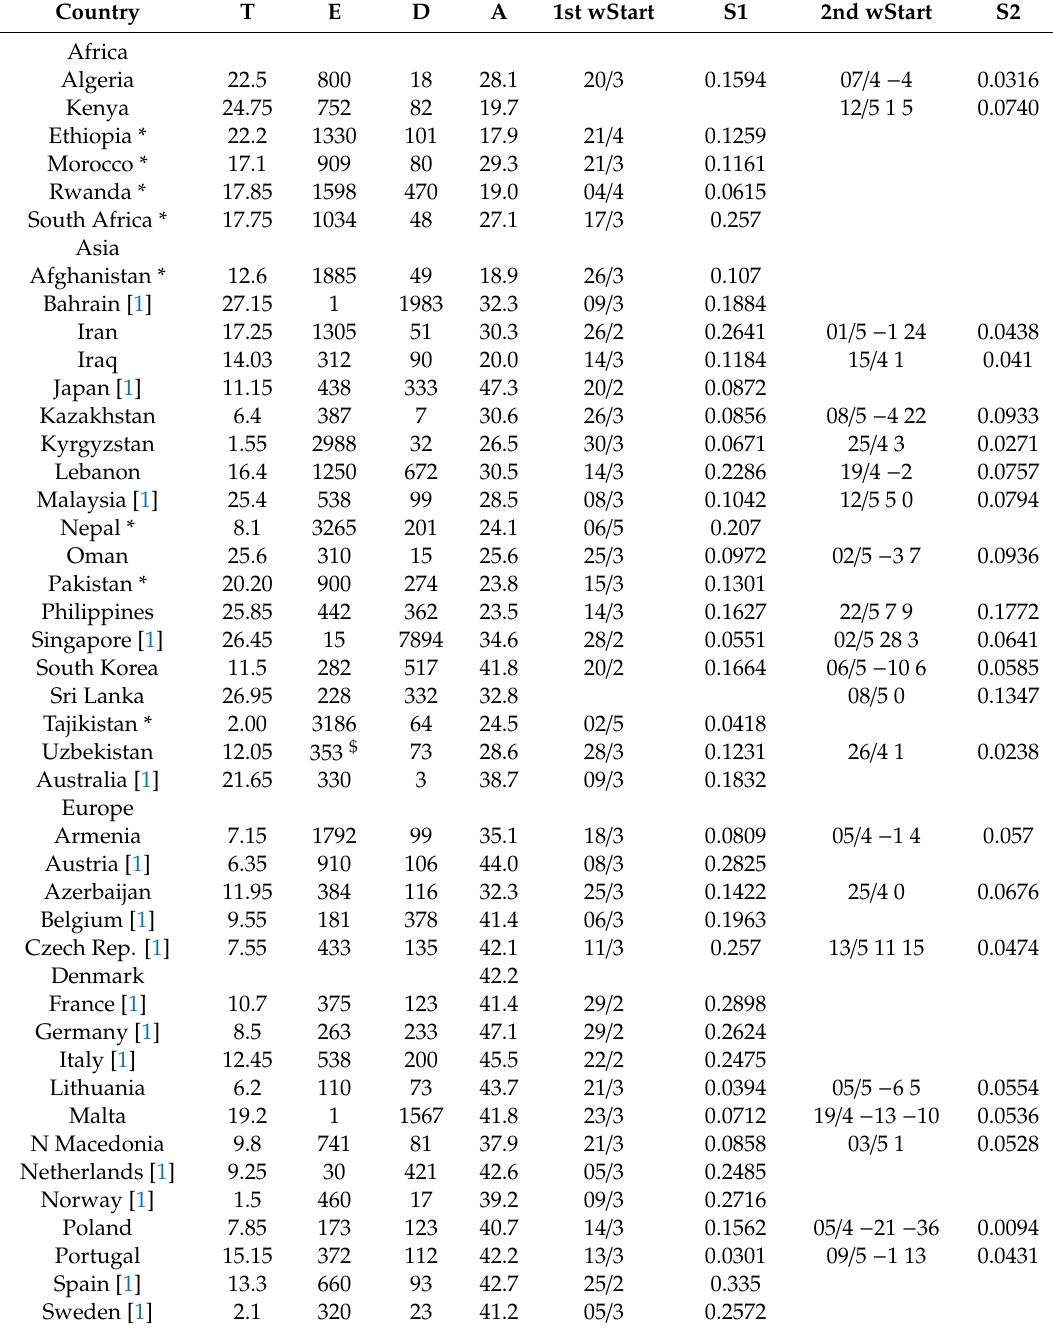
Table 1. Exponential slopes of first and second Covid-19 waves in countries with two detected waves. Columns 1, Country; Column 2, T, mean annual temperatures; Column 3, E, mean elevation; Column 4, D, density; Column 5, A, median age in that country. Start S1 for first wave is the date when cumulated total confirmed cases reached 100, start S2 for second wave is visually estimated as in Figure 3. Numbers following second wave onset date indicate di ff erences with onset dates determined by other methods, see Sections 3.11 and 3.12. Slopes are the exponent b from the exponential regression y = a ∗ exp(b ∗ x), where y is the number of new daily cases and x the number of days since 100 cumulated cases for the first wave, or second wave start. First wave data were completed by data from [1] and countries with mean elevation > 900 m (indicated with *). In Kenya and Sri Lanka, erratic data prevent estimating first wave